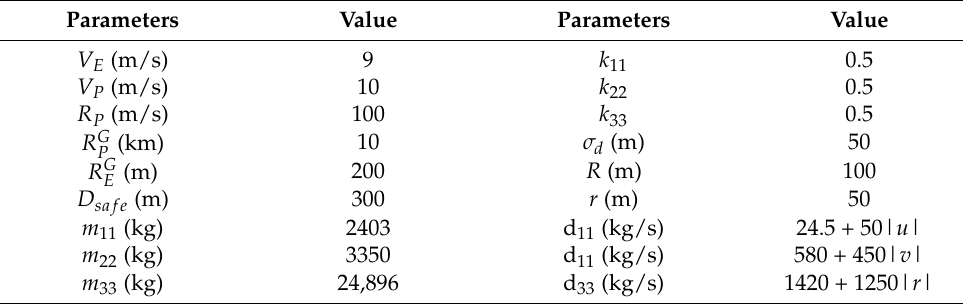
Table 1. General parameters of the USV model in simulations.